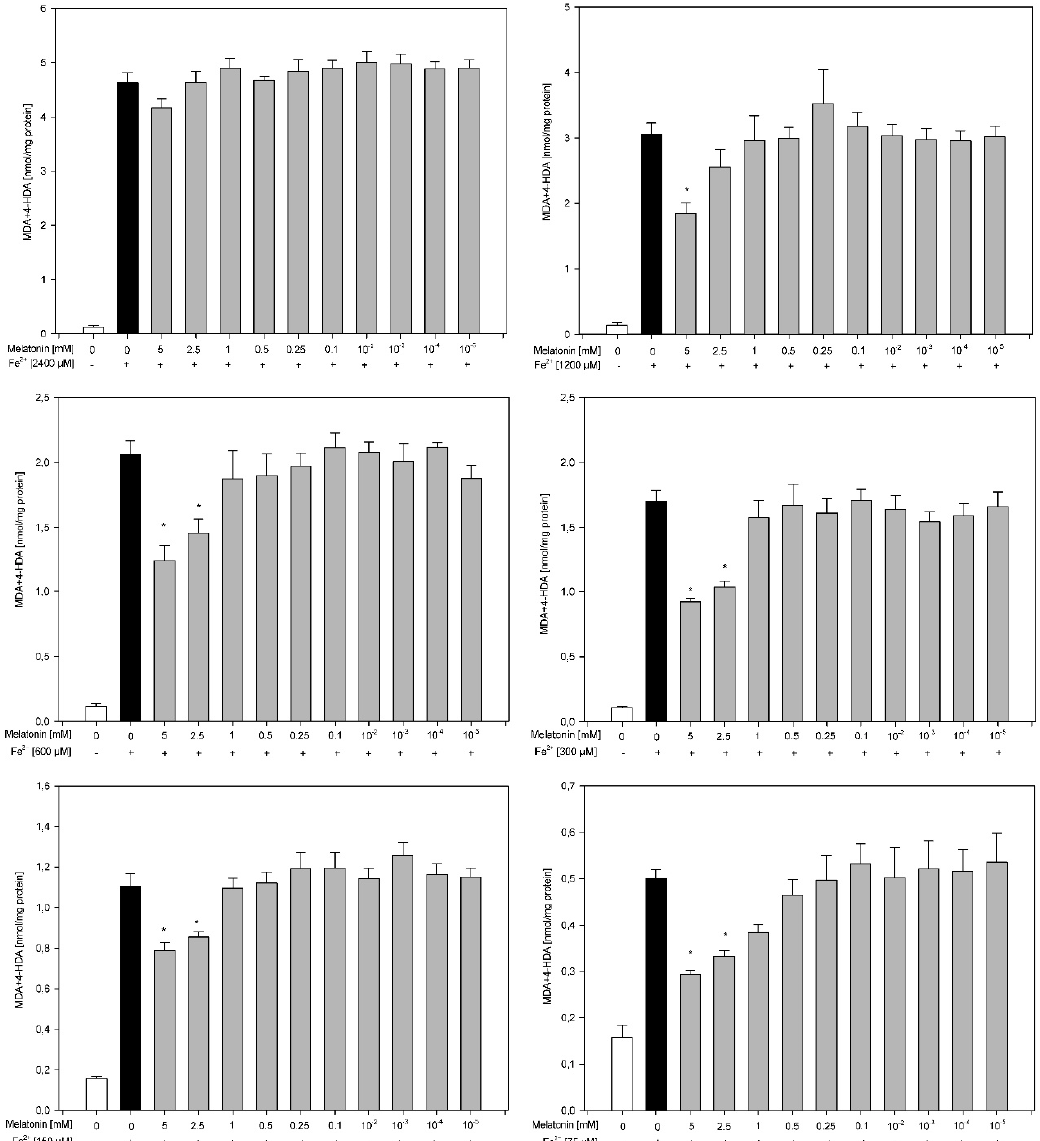
Figure 2. Concentration of malondialdehyde + 4-hydroxyalkenals (MDA + 4-HDA) in skin homogenates. Homogenates were incubated in the presence of FeSO 4 used in one of six different concentrations (2400, 120, 600, 300, 150 and 75 µM) plus H 2 O 2 (5 mM) and, additionally, in the presence of melatonin (0.0, 5.0, 2.5, 1.0, 0.5, 0.25, 0.1, 0.01, 0.001, 0.0001 and 0.00001 mM). Data are expressed as the amount of MDA + 4-HDA (nmol) per mg of protein. Bars represent the mean ± SE of three independent experiments run in duplicate. * p < 0.05 vs. respective concentration of Fe 2+ (black bars). All bars representing either Fe 2+ (black bars) or Fe 2+ plus melatonin (gray bars) are significantly higher than bars representing control (white bars).